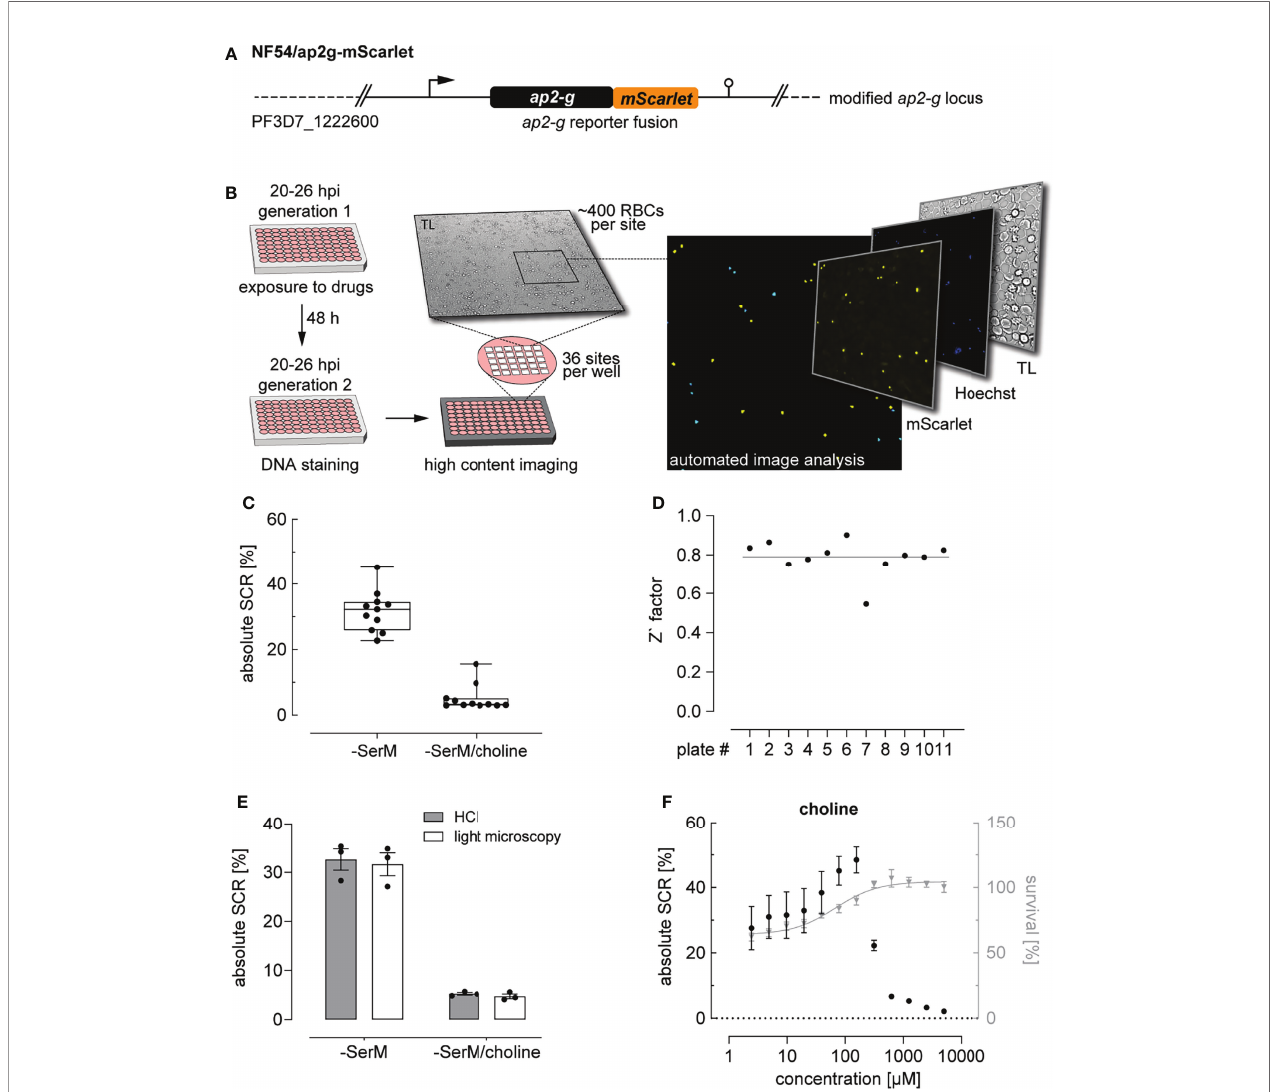
FIGURE 1 | High content imaging-based quanti fi cation of SCRs. (A) Schematic of the modi fi ed ap2-g locus in NF54/ap2g-mScarlet parasites. mScarlet, red fl uorescent protein. (B) Experimental setup of the high content imaging-based sexual commitment assay. TL, transmitted light. (C) Rates and variation of sexual commitment in NF54/ap2g-mScarlet parasites under SCR-inducing (-SerM) and inhibiting (-SerM/choline) control conditions. Boxplots show interquartile ranges; whiskers mark minimal and maximal values. Black bullets represent the mean SCRs measured in individual wells (obtained from 6 wells per screening plate) for eleven independent biological replicate experiments. (D) Z` factors determined for each screening plate. n=11; the line indicates the mean SCR across all plates. (E) SCRs and gametocyte formation rates under SCR-inducing (-SerM) and inhibiting (-SerM/choline) conditions quanti fi ed by high content imaging (HCI) and by light microscopy of stage II gametocytes on Giemsa-stained blood smears. n=3, error bars represent the standard error of the mean. (F) Dose-response effect of choline on the SCR (black bullets) and parasite survival (grey triangles). Data points represent the mean of three independent biological replicate experiments. Error bars represent the standard error of the